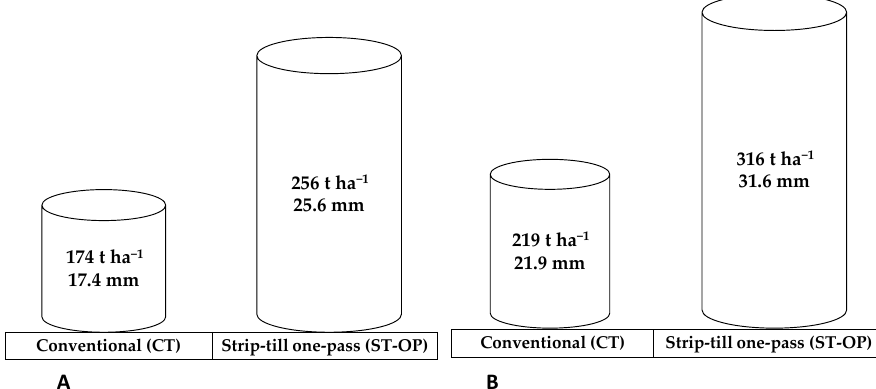
Figure5. Soilwaterreserveinthe0–20cmsoillayerinthesowingperiod. ( A Figure 5. Soil water reserve in the 0–20 cm soil layer in the sowing period. ( A ) Winter barley (from 20